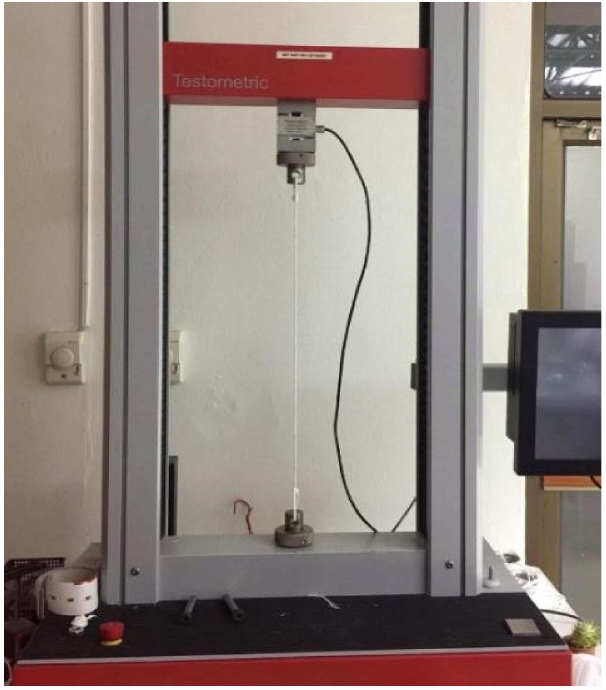
Figure 5. Typical tensile test setup for NFRRP